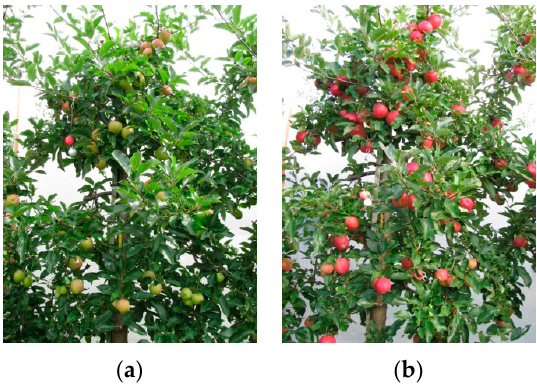
Figure 1. Sample apple tree at different times; left picture ( a ) was acquired in the early period after the June drop (period 1), about 3 months before harvest, right picture ( b ) was acquired during the ripening period (period 2), about 15 days before harvest. Table 2. Description of parameters for yield prediction.